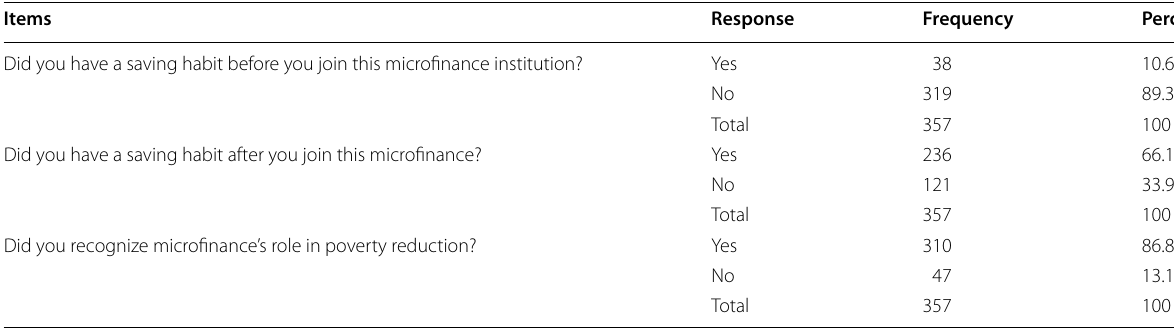
Table 6 Respondents attitude about saving. Source : Author’s Survey